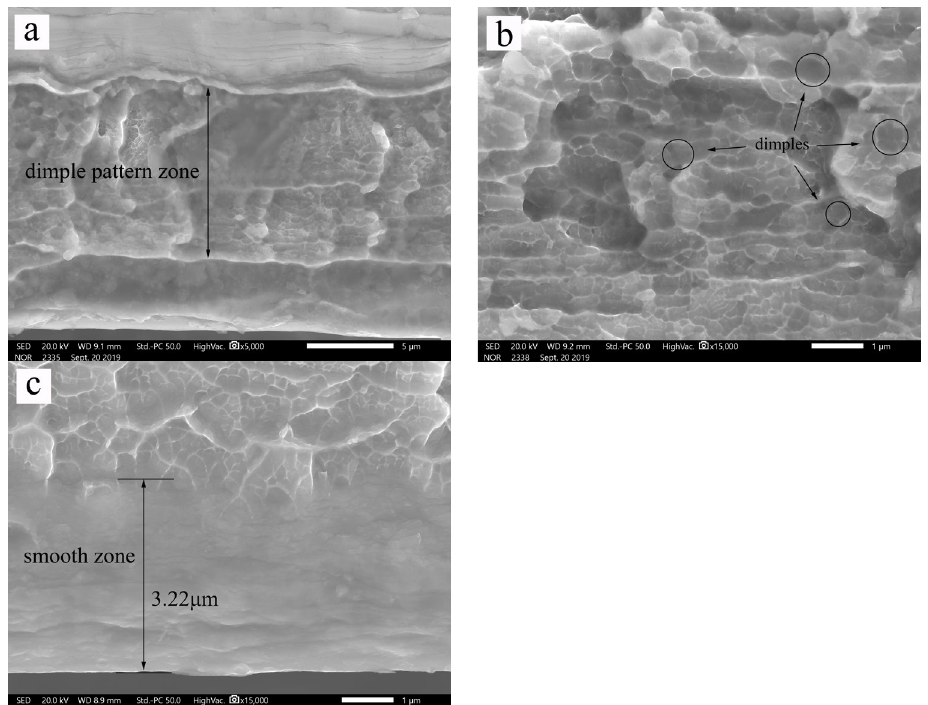
Figure 5. Fracture surfaces for S25: micro-scaled dimple pattern zone ( a ); enlarged images for dimple ( b ); smooth zone ( c ).